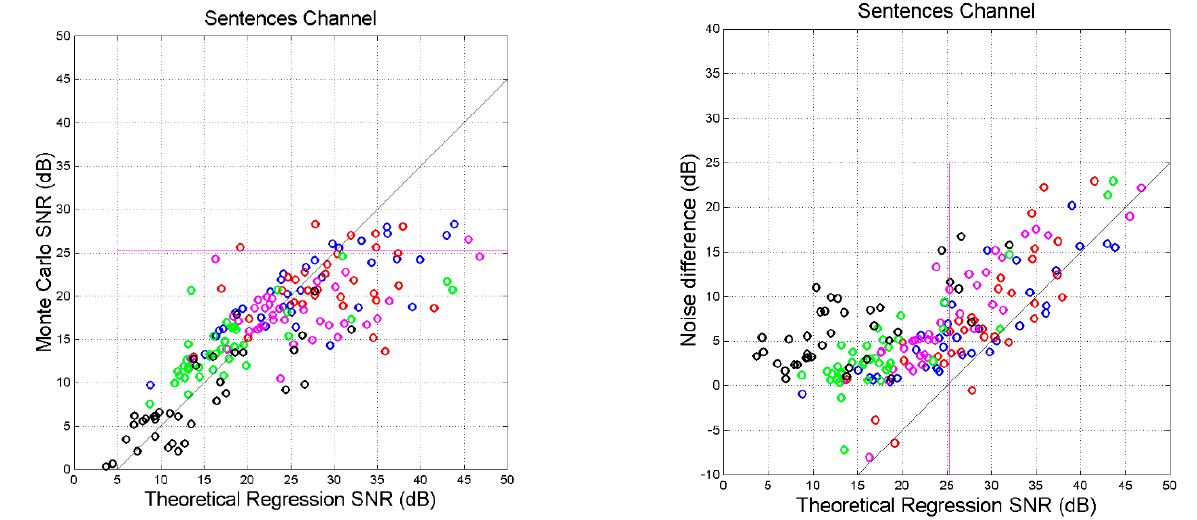
Figure 11. ( Left panel ): Scatter plot between the theoretical partial signal-to-noise ratio Γ m , dB , th and the experimental Γ m , dB , ex in the indicated cross-links. ( Right panel ): Difference Γ m , dB , th − Γ m , dB , ex , i.e., the ratio (expressed in dB) between the noise power in the experimental channel and that in the theoretical channel. Color key : blue = Mt vs. Mk; red = Mt vs. Lk; magenta = Mt vs. Jh; green = Mt vs. Ac; black = Mt vs. Ap. The magenta line corresponds to Greek self ‐ channel.